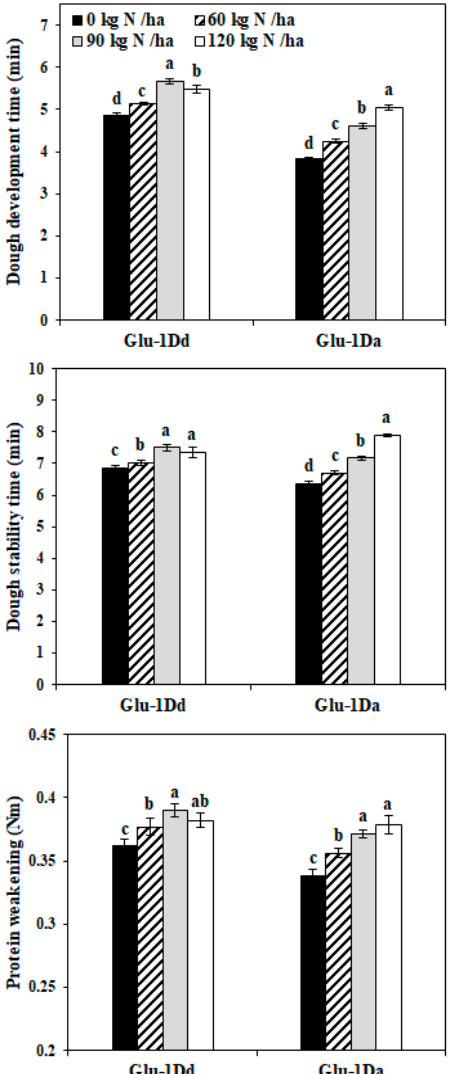
Figure 6. Mixing properties of dough in lines with Glu-1Dd and Glu-1Da under N treatment. The same letter in the different columns for each material indicates no significant difference ( p > 0.05). Data are presented as the mean of two years.